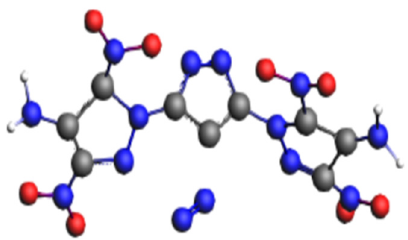
Figure 9. Rupture of C-N bond in the LLM-226 molecule.